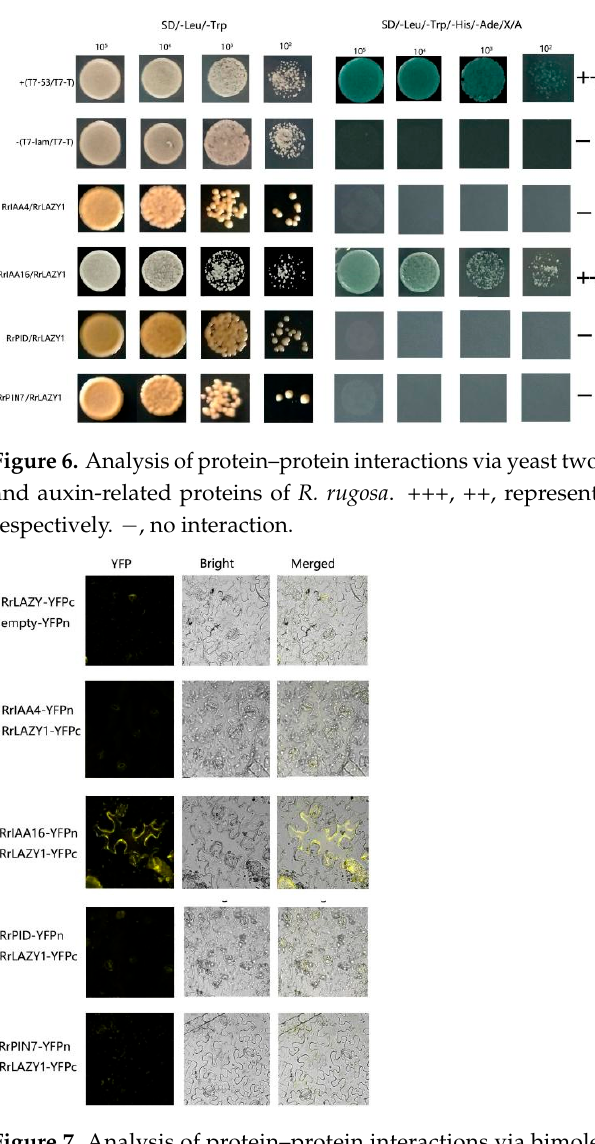
Figure 7. Analysis of protein–protein interactions via bimolecular fluorescence complementation experiments between RrLAZY1 and auxin-related proteins of R. rugosa . RrLAZY1-YFPc/RrIAA16- YFPn interact on the cell membrane. There was no yellow fluorescence signal in the control group or other combinations. YFP: YFP fluorescence; Bright, bright field; Merged, superimposition of bright field and